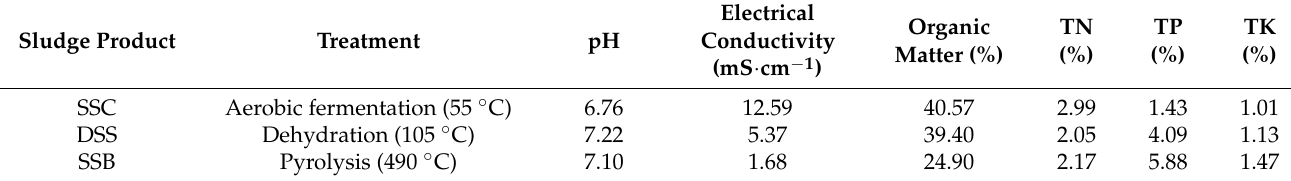
Table 2. Physical and chemical properties of three sewage sludge